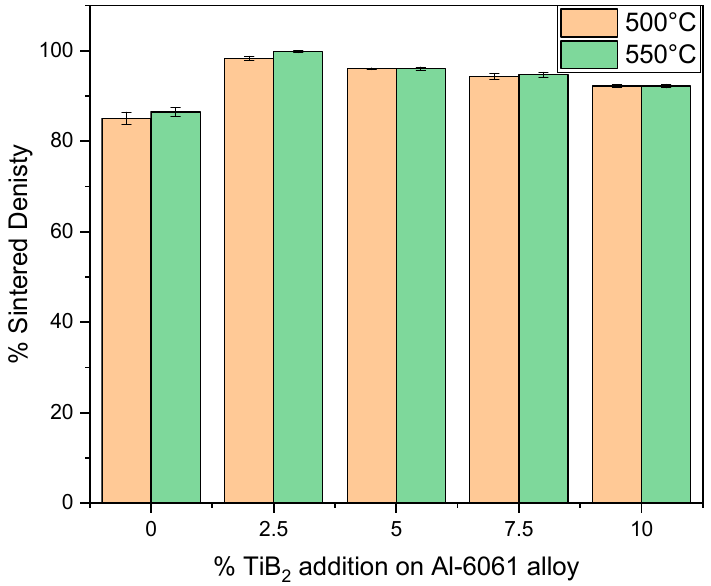
Figure 2. Sintered density of Al-TiB 2 composites.